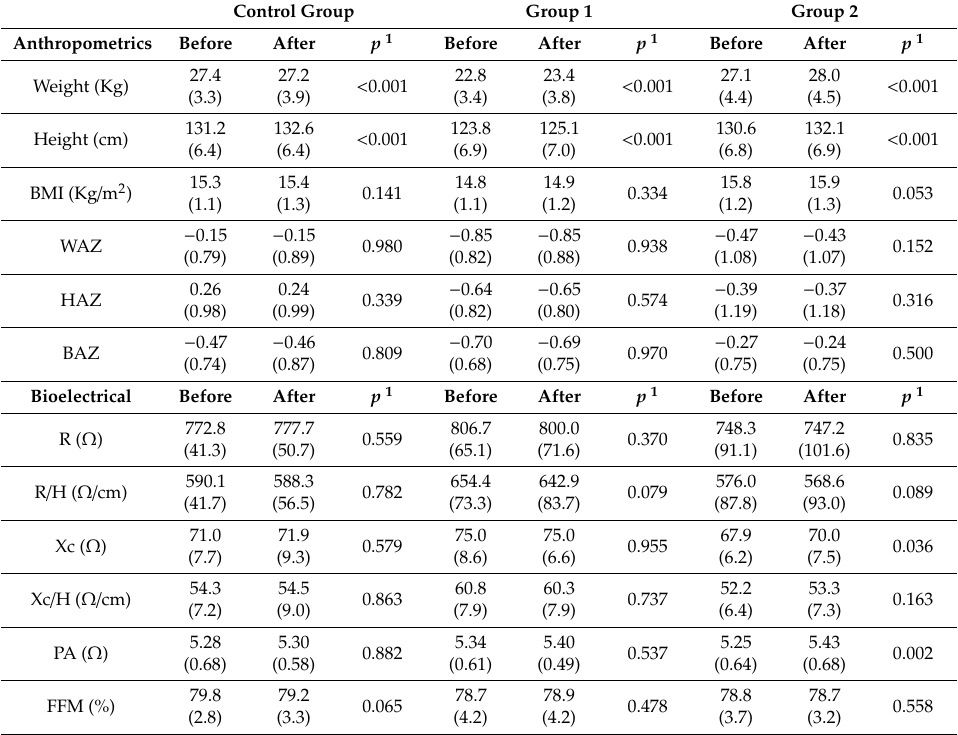
Table 2. Anthropometric characteristics and bioelectric parameters before and after oral supplementation with di ff erent concentrations of zinc.